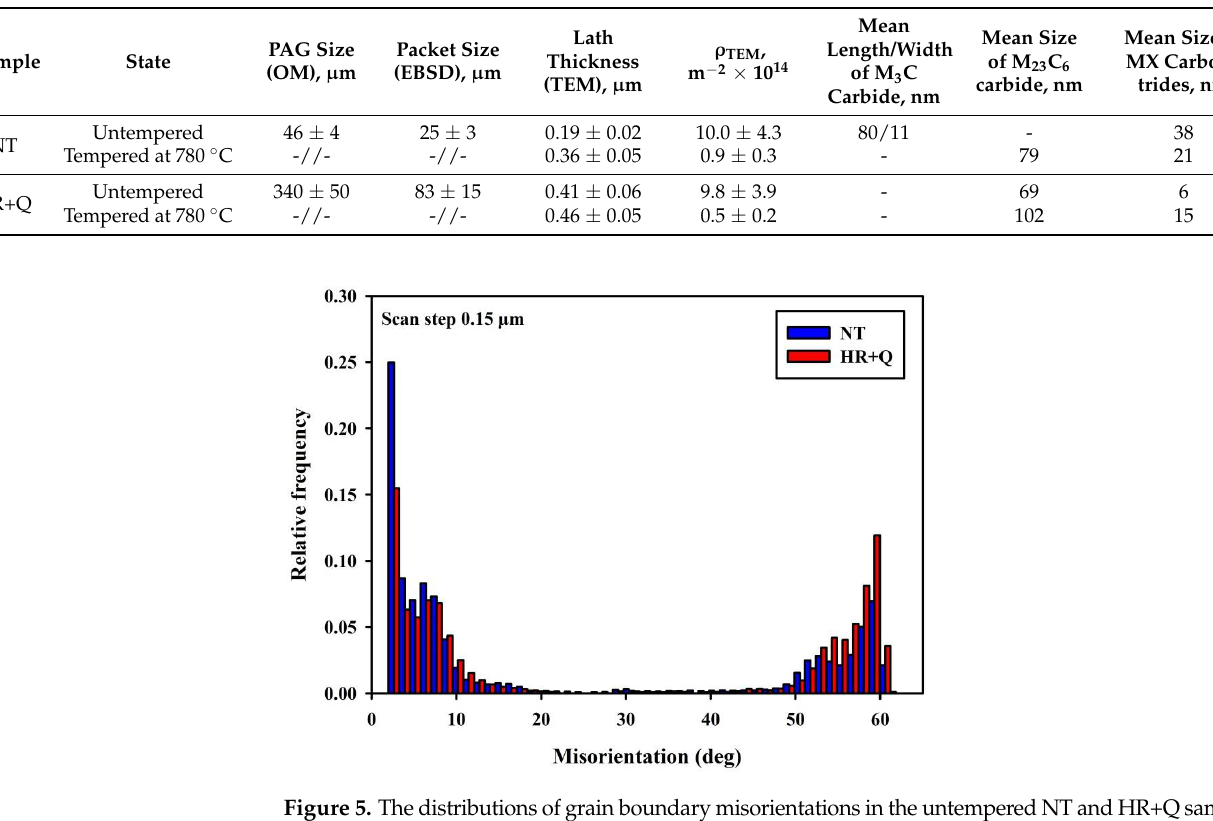
Figure 6. TEM images of lath martensite in the untempered NT ( a ) and HR+Q ( b ) samples. The suppressed lath/subgrain boundary migration during tempering of the steel af- ter HR+Q treatment may be due to the pinning effect from the thermodynamically stable carbide particles. The selected area diffraction (SAD) and EDX analysis of the secondary precipitates in the untempered HR+Q sample reveal the presence of M 23 C 6 particles with